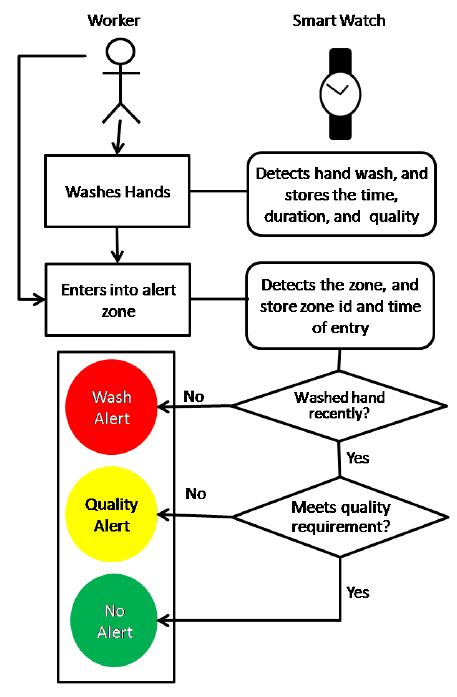
Figure 3: Workflow in